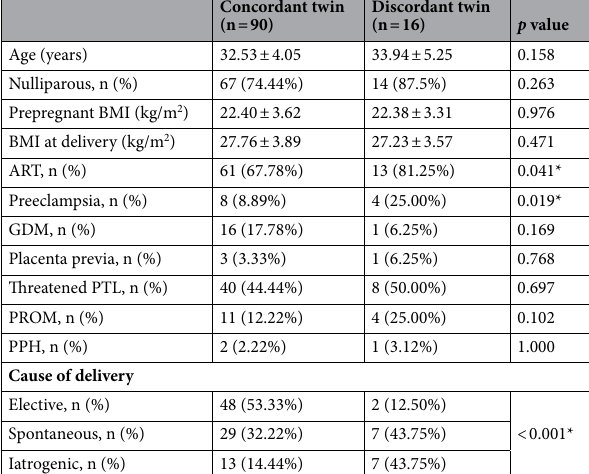
Table 3. Comparison of maternal characteristics and pregnancy-related complications between concordant and discordant twins at 28–32 weeks of gestation in DCDA twins. DCDA, dichorionic diamniotic; BMI, body mass index; ART, artificial reproductive technique; GDM, gestational diabetes mellitus; PTL, preterm labor; PROM, premature rupture of the amniotic membrane; PPH, postpartum hemorrhage. * p values of < 0.05 are shown in bold with an asterisk